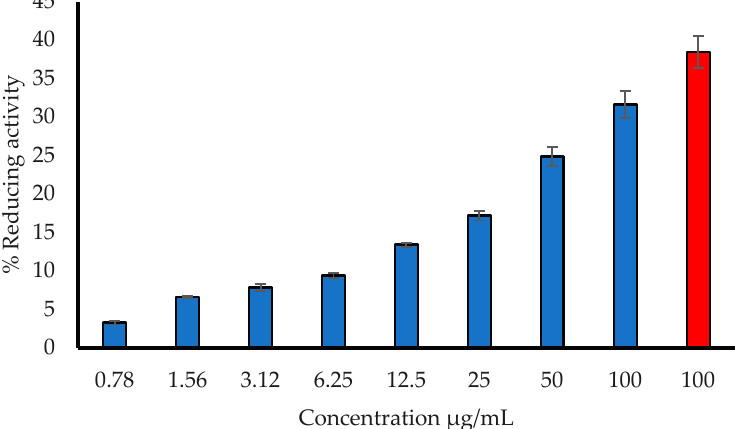
Figure 1. Percentage H 2 O 2 scavenging activity of garlic extract. Various concentrations of garlic extract (0.78, 1.56, 3.12, 6.25, 12.5, 25, 50, and 100 µg/mL) (blue column). The red column belongs to 100 µg/mL of standard antioxidant “Ascorbic acid”.